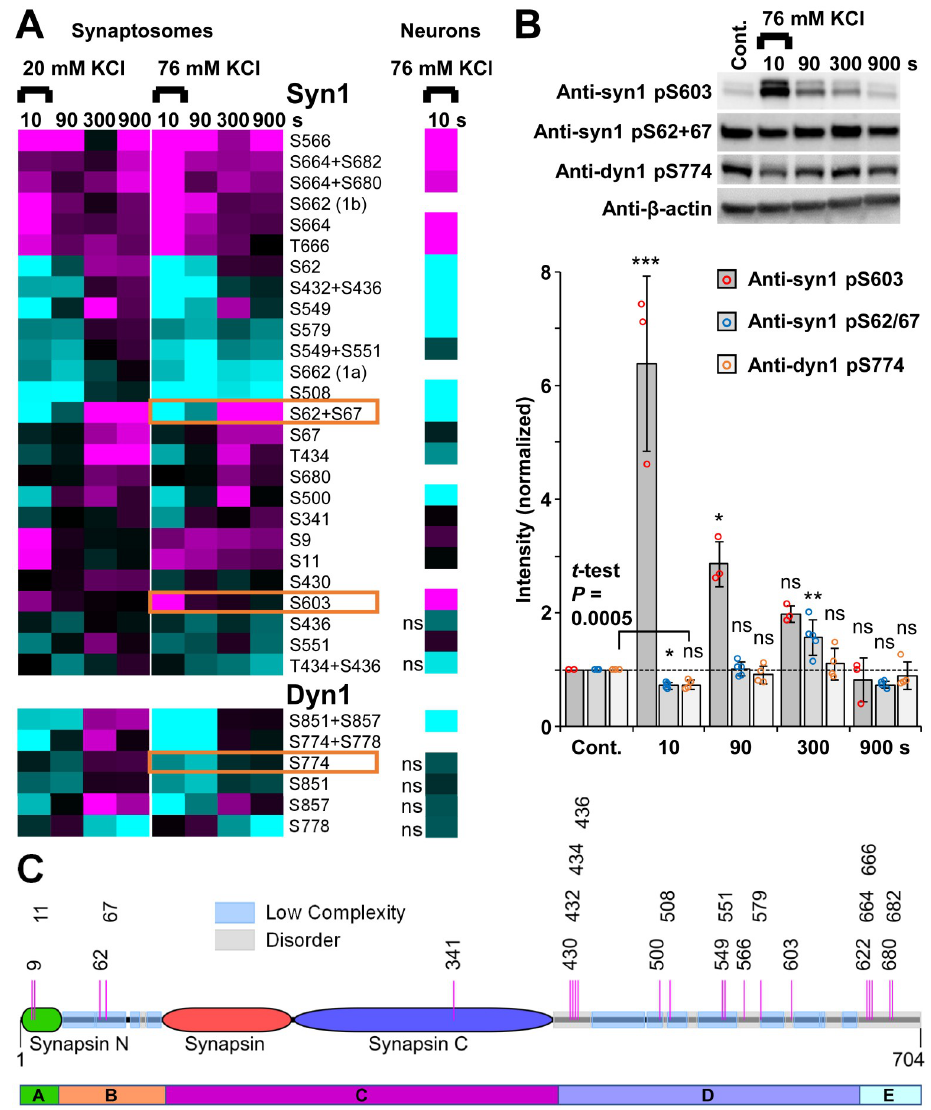
Fig 3. Validation of stimulus and poststimulus phospho-signalling. (A) Heat map of significantly regulated phosphorylation sites for syn1 (upper) and dyn1 (lower) from 20 mM and 76 mM KCl stimulated synaptosomes (left, n = 6) and a single 10-s time point of 76 mM KCl stimulated hippocampal neurons (right, “ns” means not significantly regulated, n = 3). The log 2 (stimulated intensity/control intensity) is shown using the same colour scale as Fig 2B. Note: phospho-S662 in syn1 was detected with differential regulation from 1a and 1b isoforms. The synaptosome data are the result of six independent experiments for each stimulation condition (20 mM and 76 mM KCl). The cultured hippocampal neuron data are from three independent experiments. (B) Representative western blots of syn1-pS603, syn1-pS62+S67, dyn1-pS774, and β -actin loading control for 76 mM KCl depolarized and repolarized synaptosomes. Bar graphs of the densitometry of the western blots, after correction for loading, are shown (below). The intensities were normalized to the control (“Cont.”)/mock stimulation. The bar graphs show the mean and standard deviation of 3 (syn1 pS603), 4 (dyn1 S774), or 5 (syn1 S62+S67) independent experiments. Statistical significance was determined by one-way analysis of variance with Dunnett’s post hoc test; � P < 0.05; �� P < 0.01; ��� P < 0.001; in (B), “ns” means “not significant”. P = 0.0005 using Student t test to compare dyn1-pS774 intensity at 10 s versus control and P = 0.17 when adjusted for multiple comparisons (time points). The heat map rows in (A) for the sites examined in (B) are boxed. Underlying data for this figure can be found in S1 Data. (C) Domain structure of Syn1 using A-E domain naming [39] and Pfam evolutionarily conserved domains [34] with the activity-dependent phosphorylation site positions indicated. dyn1, dynamin 1; syn1, synapsin